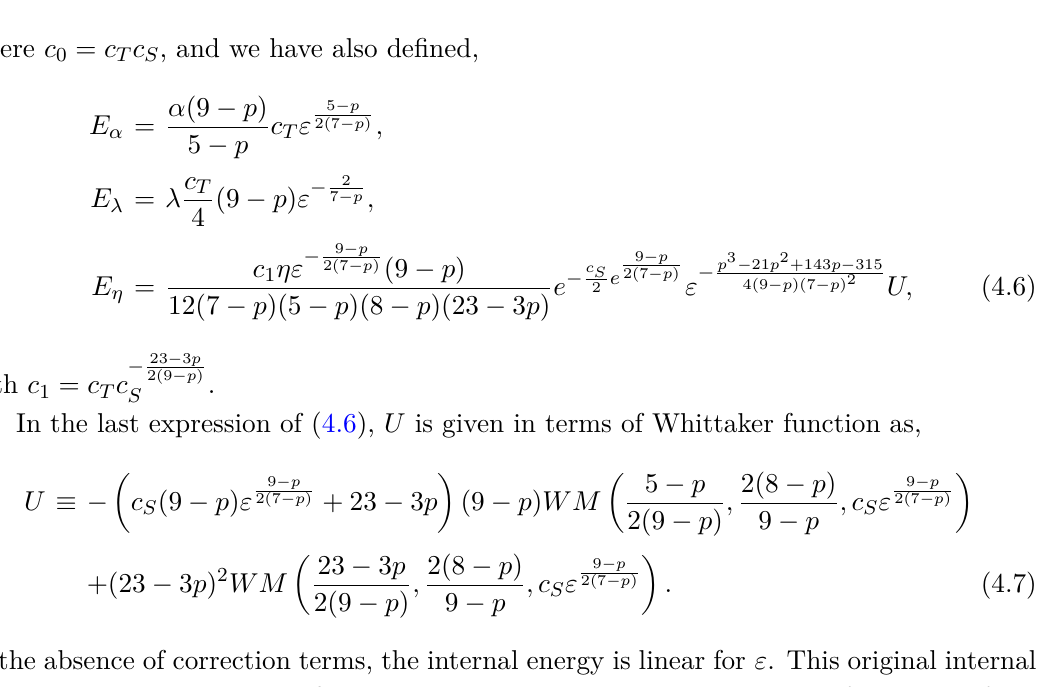
Figure 4 . Effect of logarithmic correction on the internal energy for c T = c S = 1